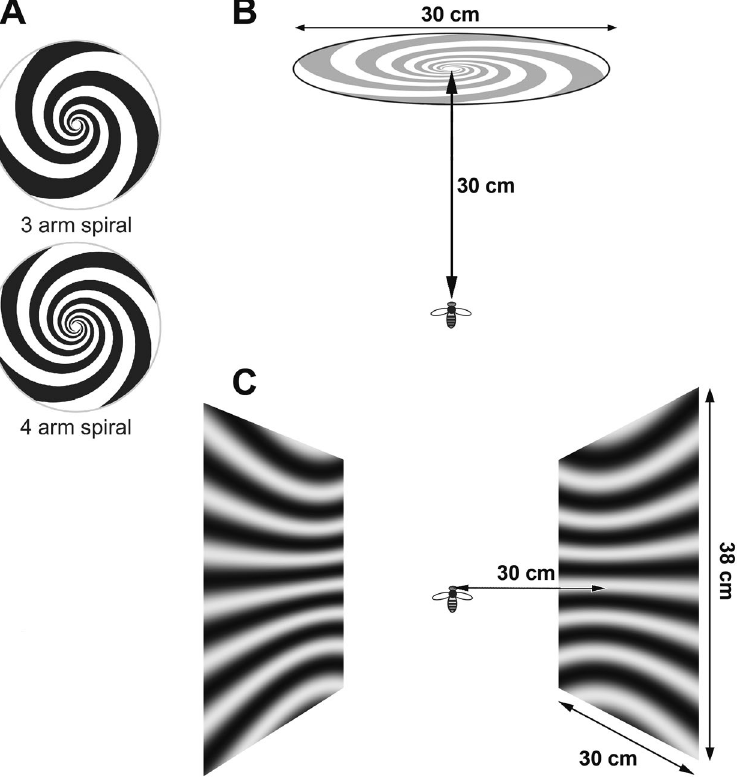
Figure 1. Stimulus configurations. ( A ) 3-arm and 4-arm spirals used for frontal stimulation. ( B ) Positioning of the bee relative to the frontal spiral stimulus. ( C ) Illustration of the lateral stimulus